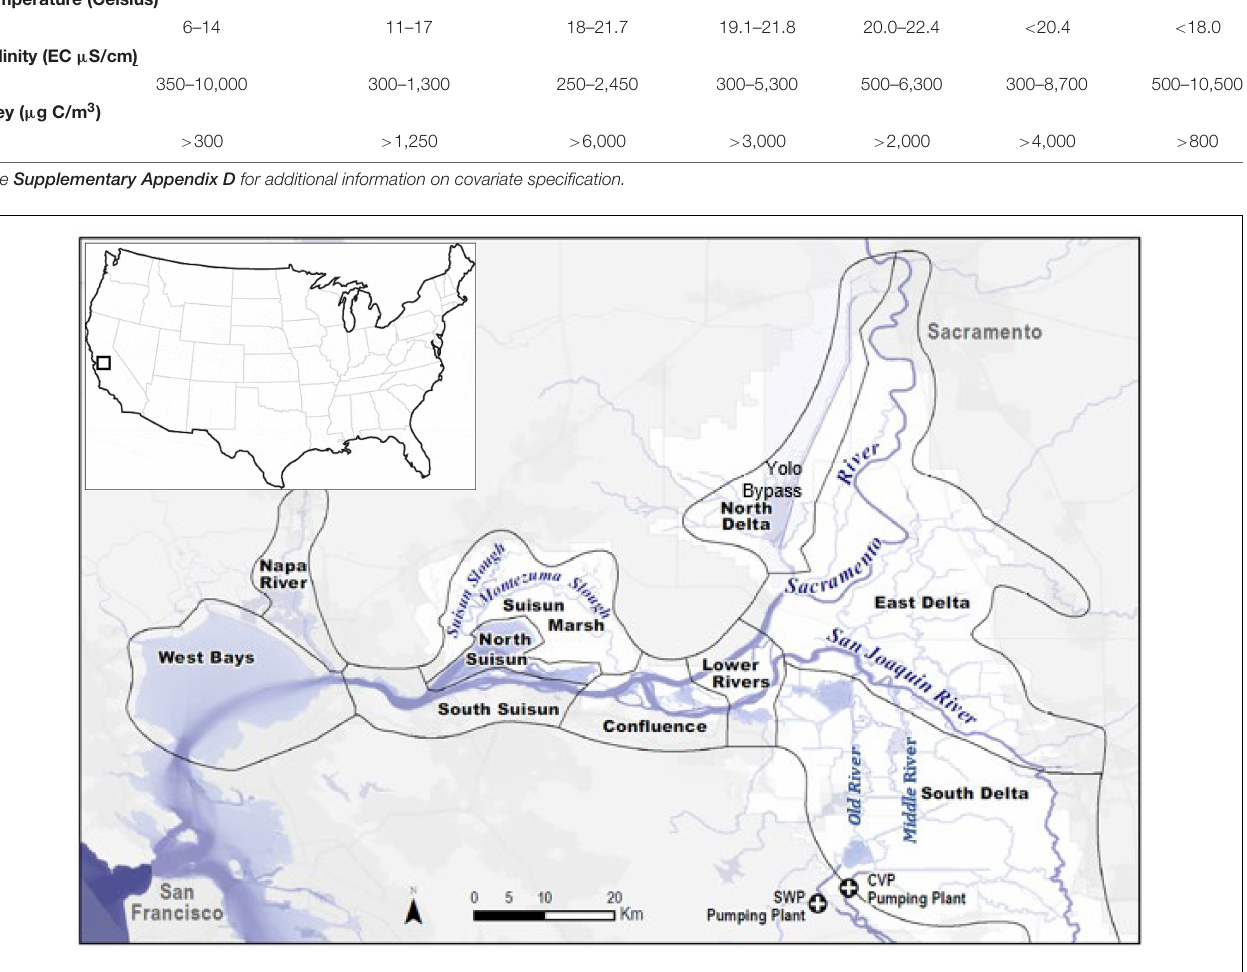
of delta smelt was determined by calculating the percentage of delta smelt in each subregion over each 2-month period throughout the